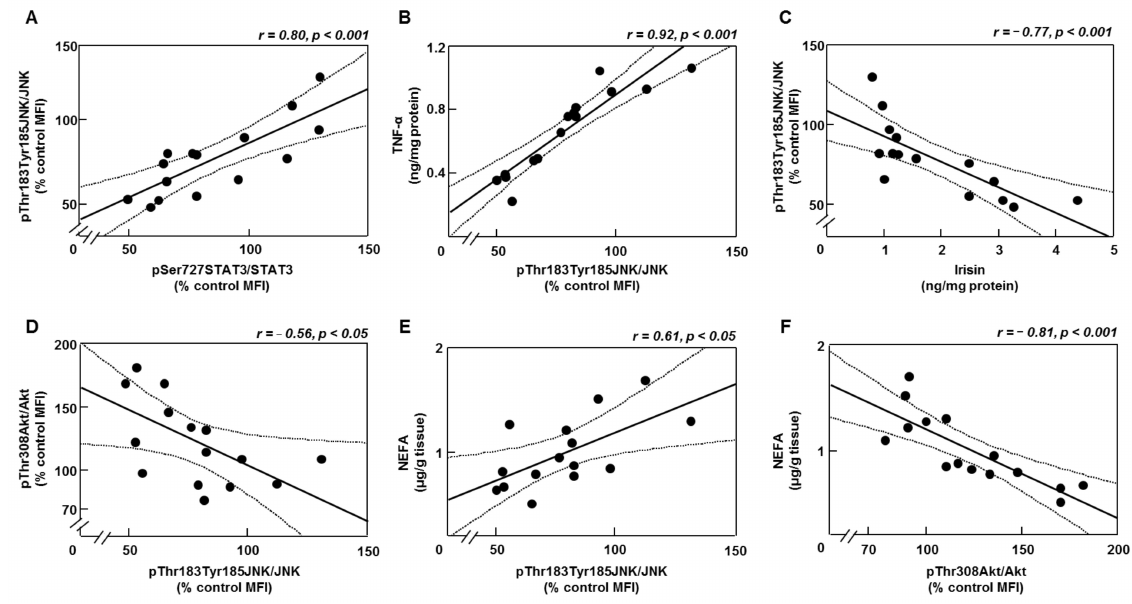
Figure 6. Correlations between leptin-, inflammatory- and insulin-related targets in gastrocne- mius. ( A ) Linear correlations between relative protein levels of c-Jun N-terminal kinase (JNK) phosphorylated on Thr183 and Tyr185 (pThr183Tyr185JNK) and signal transducer and activator of transcription 3 (STAT3) phosphorylated (p) on Ser727 (pSer727STAT3), ( B ) tumor necrosis fac- tor (TNF) α and pThr183Tyr185JNK, ( C ) pThr183Tyr185JNK and irisin, ( D ) Akt phosphorylated on Thr308 (pThr308Akt) and pThr183Tyr185JNK, ( E ) non-esterified fatty acid (NEFA) content and pThr183Tyr185JNK and ( F ) NEFA and pThr308Akt. MFI, median fluorescent intensity. The 95% confi- dence interval is indicated by hatched curves. Correlation coefficients (r) and p values are represented for each analysis. Dots represent the individual